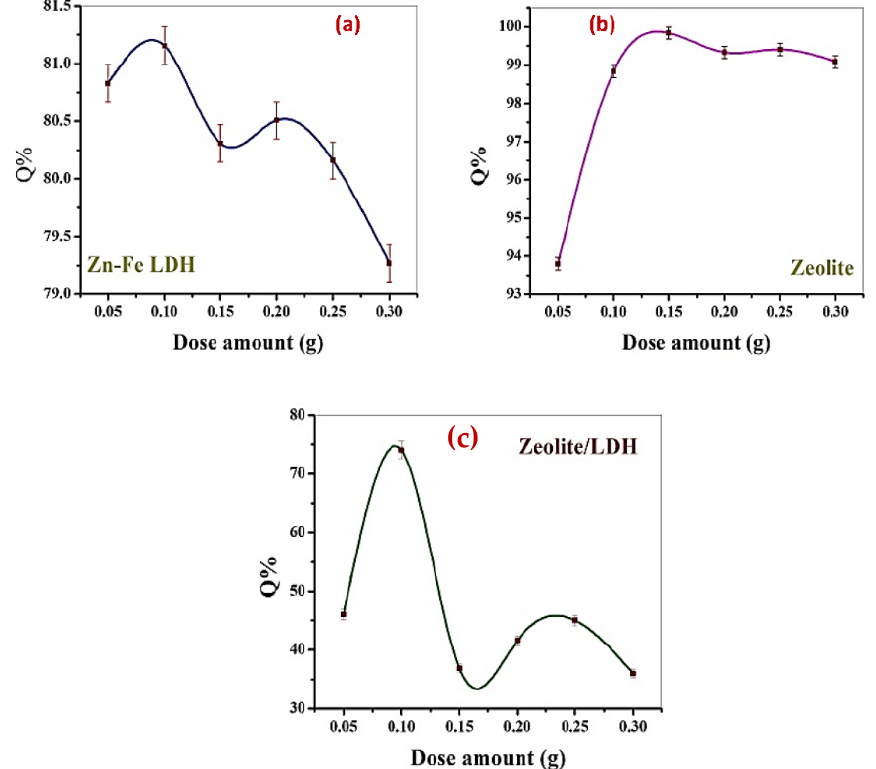
Figure 8. The effect of adsorbent dose on the adsorption of MB using Zn-Fe LDH ( a ) zeolite ( b ), and zeolite/LDH nanocomposite ( c ).